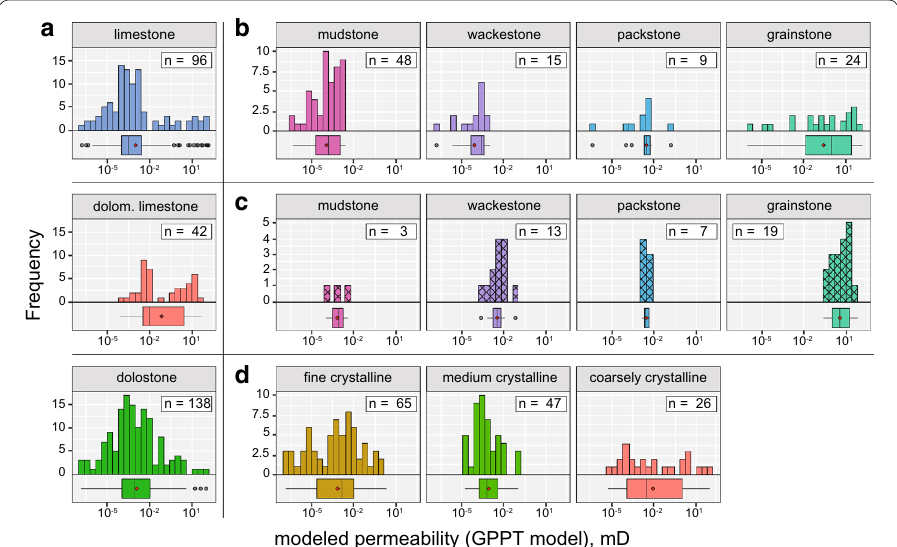
Fig. 14 Distribution of the permeability modeled by the GPPT for different lithology and facies classes. a The permeability is normally distributed within the limestone and dolostone groups, but shows a wide scattering over several orders of magnitude. Dolomitic limestone shows on average higher permeability with a bimodal distribution. b – d The permeability tends to be higher with increasing particle size for (dolomitic) limestone. Dolostone shows a similar correlation with the crystal size, but not as pronounced as for the limestone